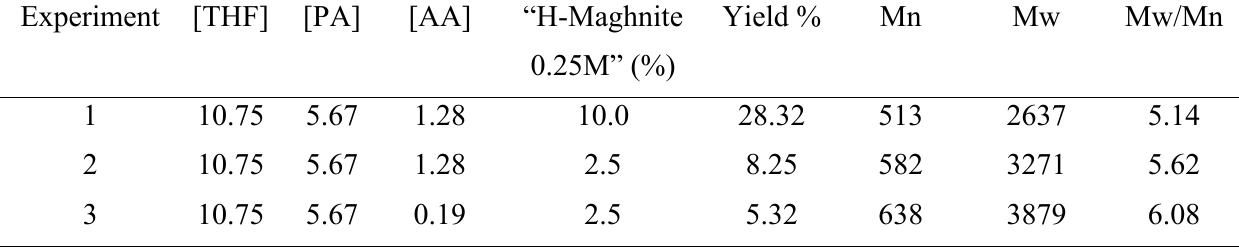
Table 3. Polycondensation of THF with phthalic anhydride induced by the “H-Maghnite 0.25M”